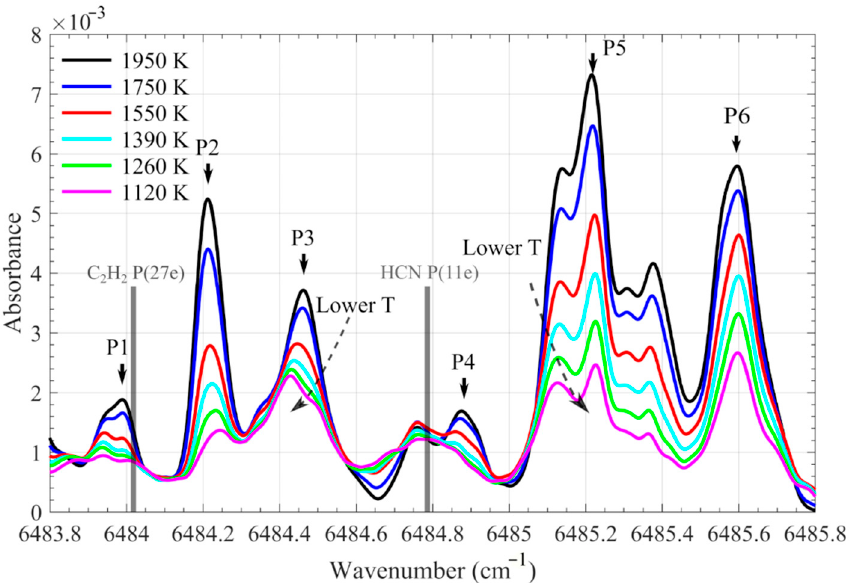
Figure 5. Measured H 2 O absorbance spectra between 6483.8 and 6485.8 cm − 1 at temperatures of 1120, 1260, 1390, 1550, 1750, and 1950 K. The absorbance was corrected to a value with an identical H 2 O number density, 4.7 × 10 17 molecules/cm 3 (10% at 1500 K). The typical six absorption peaks are labeled in the figure. The chosen lines for HCN and C 2 H 2 are marked with vertical bars.